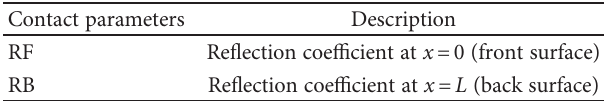
Table 3: Re fl ection coe ffi cient for light impinging on the front and back surfaces.